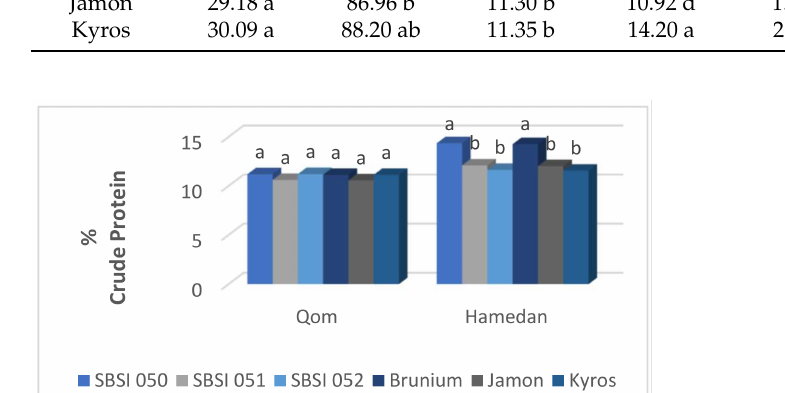
Figure 7. The interaction effects of location × genotype on root crude protein. Means followed by the same letter(s) is/are not significantly differ at 5% level of probability.